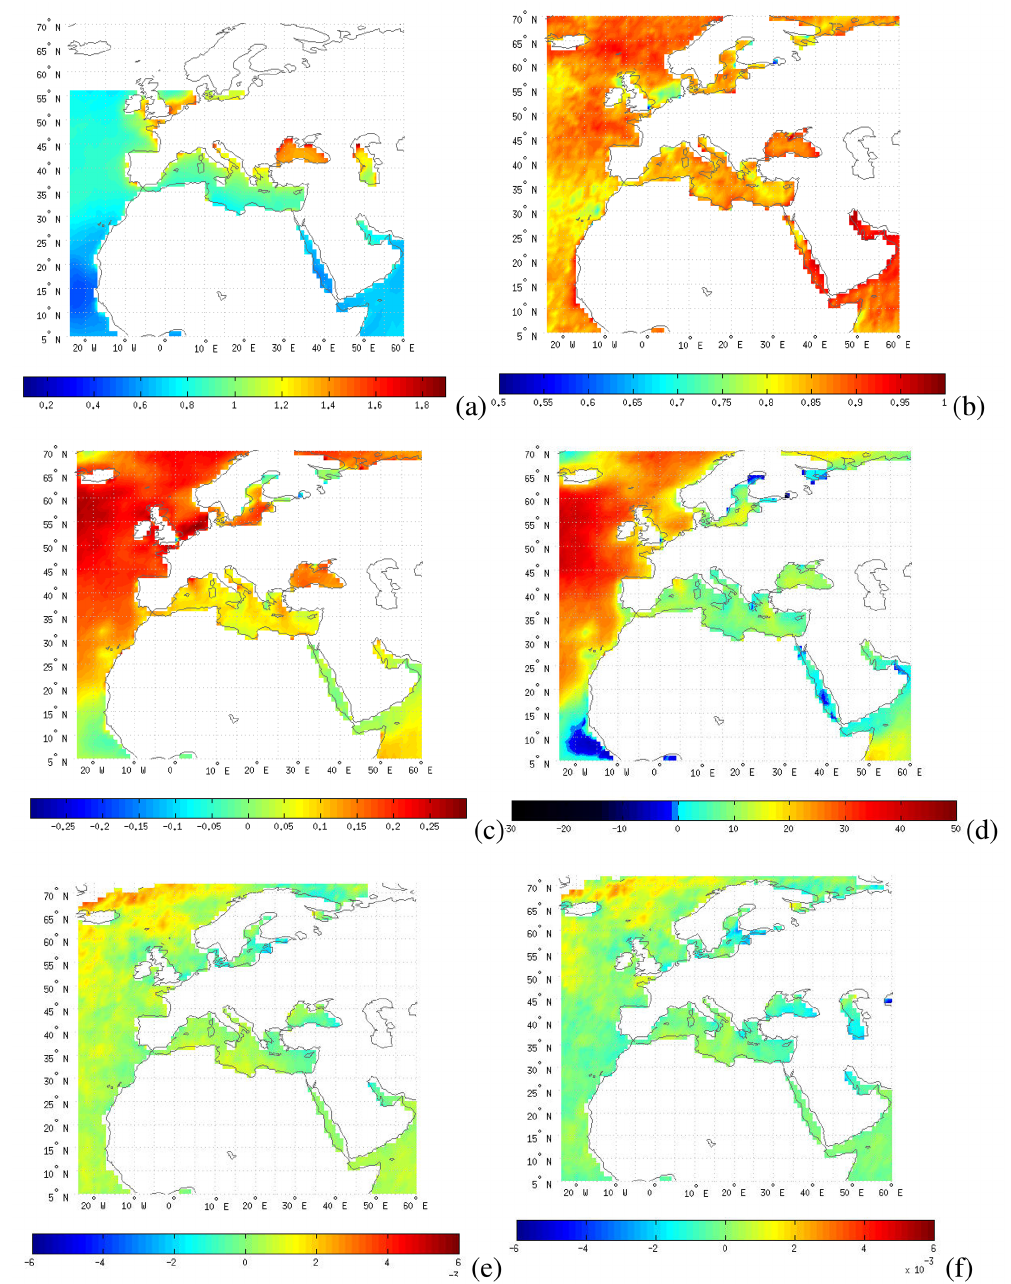
Figure 8. (a) Geographical distribution of MODIS-Aqua C006 Ångström exponent (AE 550 − 865 ) values averaged over 2002–2010, at the wavelength pair of 550–865nm. Winter AE data are missing from the northernmost areas, and therefore the long-term averages in (a) are left blank. In (b) , (c) and (d) are given the correlation coefficients, the absolute biases and the relative percent biases, respectively, between the C006 and corresponding 051 AE 550 − 865 data. In (e) and (f) are given the computed de-seasonalized trends of MODIS Aqua 051 and C006 AE 550 − 865 ) slope values for years 2002–2010,